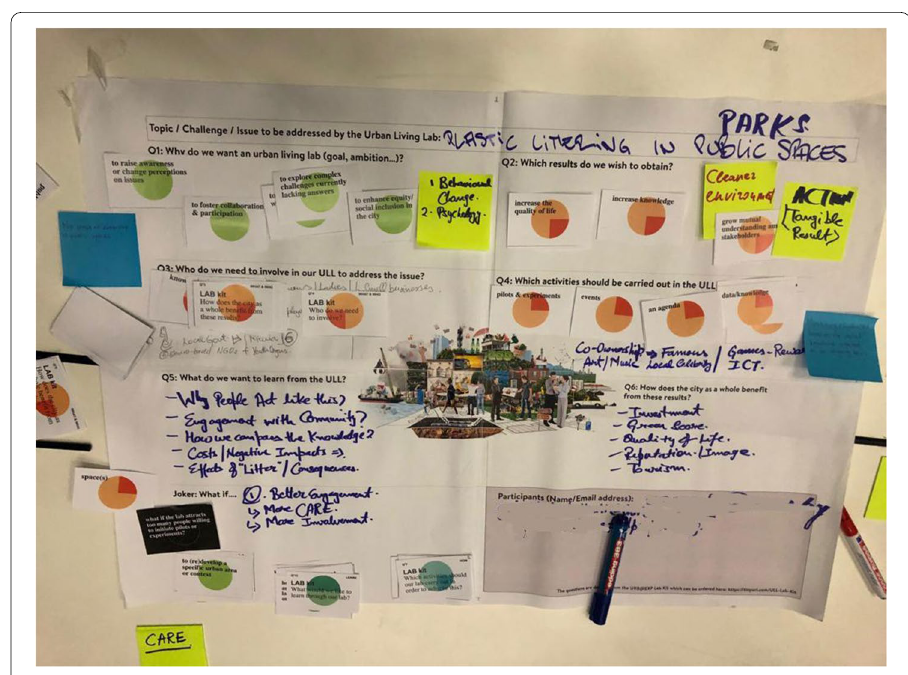
Fig. 2 An urban living lab dialogue session using the URB@Exp Lab kit as a tool to articulate issues and concerns with the approach, at the UCLG Durban 2019. Photo: Johannes Riegler